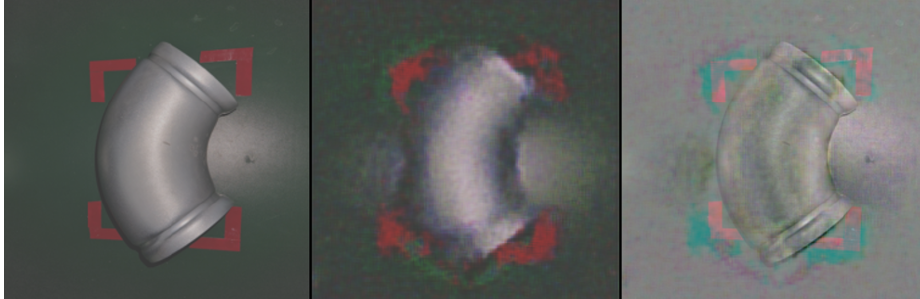
Figure 12. Normal Image Data